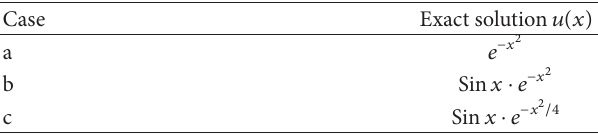
Table 1: Three cases of the exact